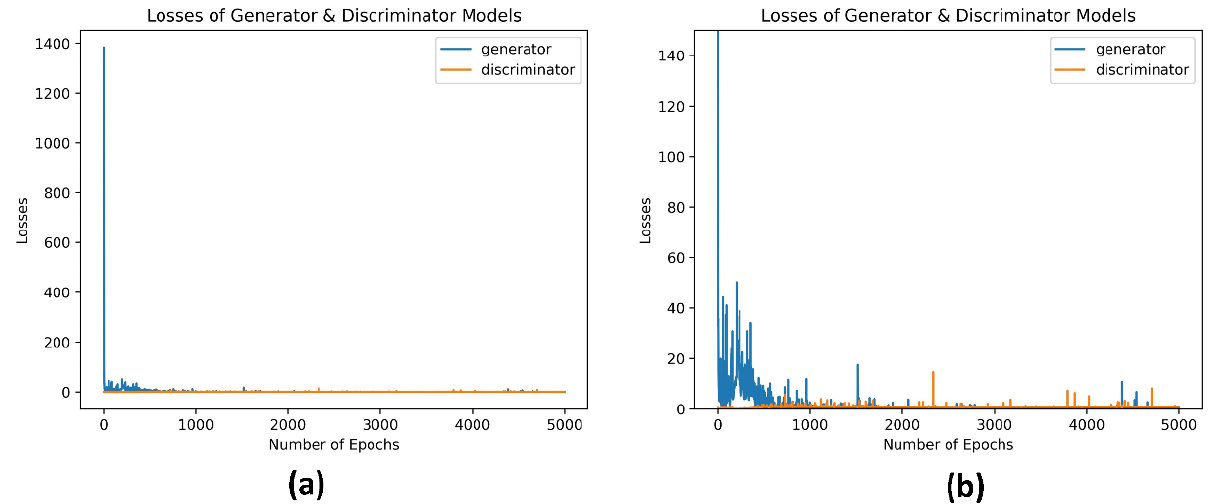
Figure 5. ( a ) Generator and discriminator losses full scale. ( b ) Generator and discriminator losses zoomed in scale 0 – 150.